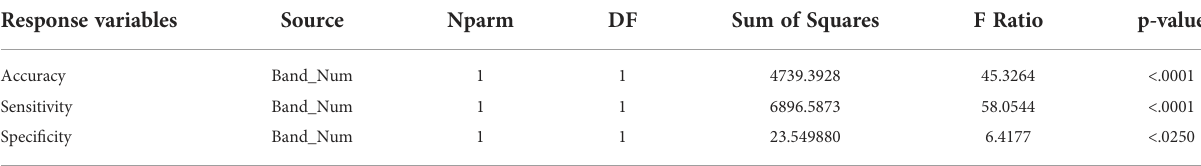
TABLE 5 Fixed-effect model test to see if the number of PCA-based bands has any effect on accuracy, sensitivity, and speci fi city. . Response